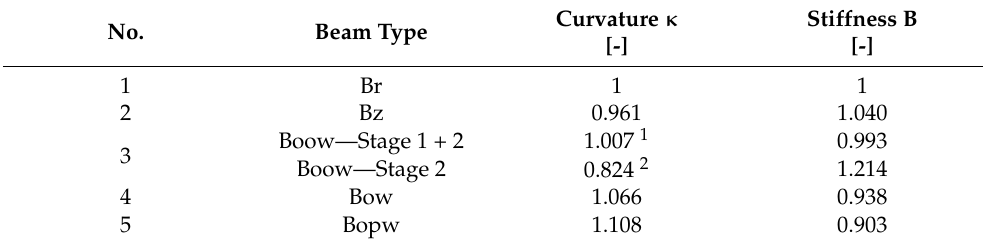
Table 8. Relative curvature and relative stiffness of beams strengthened using CFRP strips in compar- ison with reference beam at load of 60 kN (which corresponds to design load-carrying capacity of reference beam) based on experimental results.